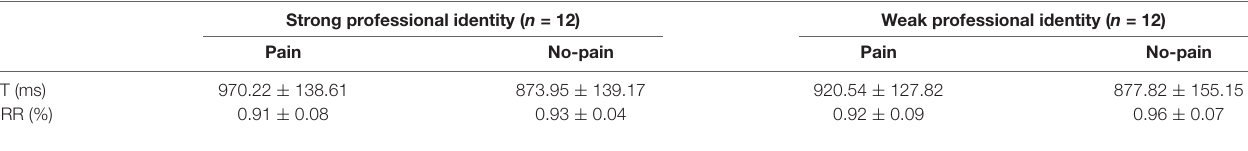
TABLE 1 | Mean reaction time (RT) and correct response rate (CRR) of the pain empathy task (M ±